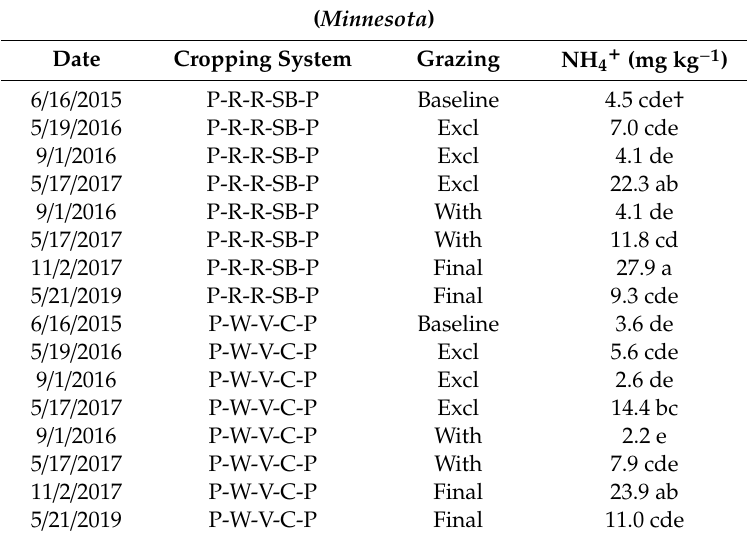
Table 6. NH 4 + as a function of the interaction between sampling date, cropping systems, and grazing in Minnesota